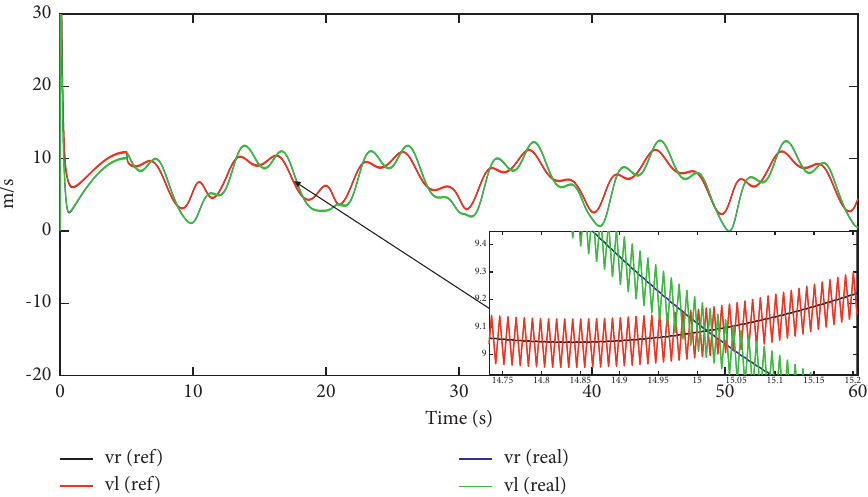
Figure 8: The real velocity of T-S fuzzy type-I for trifolium trajectory. Table 1: Numerical comparison between the proposed controller and T-S fuzzy type-I